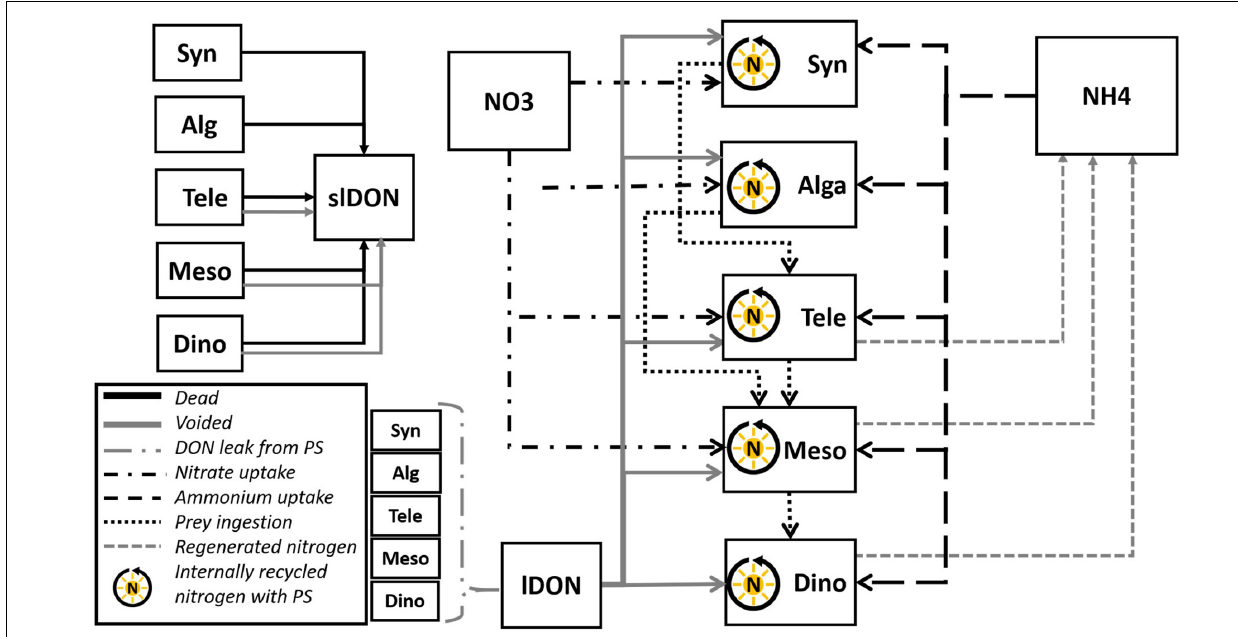
FIGURE 2 | Schematic of the Teleaulax - Mesodinium - Dinophysis (TMD)-complex food-web simulator. The model comprises four state variables describing the nutrient sources nitrate (NO3), ammonium (NH4), and lDON and slDON. It also includes five state variable descriptions of plankton functional types (PFT)—a constitutive mixoplankton Teleaulax (Tele), two plastidic specialist non-constitutive mixoplankton Mesodinium (Meso) and Dinophysis (Dino), the cyanobacteria Synechococcus (Syn), and generic protist phytoplankton (Alga). All the five PFTs are mixotrophic by virtue of engaging in photosynthesis and heterotrophic use of DON; however, only Tele, Meso, and Dino can engage in phagotrophy and are thus mixoplanktonic. All organisms leak DON. Nitrate (NO3) is available for use by all PFTs except Dinophysis . Voided and dead organic material contributes to the DON pools; these degrade to ammonium (NH4) via an implicit microbial loop.